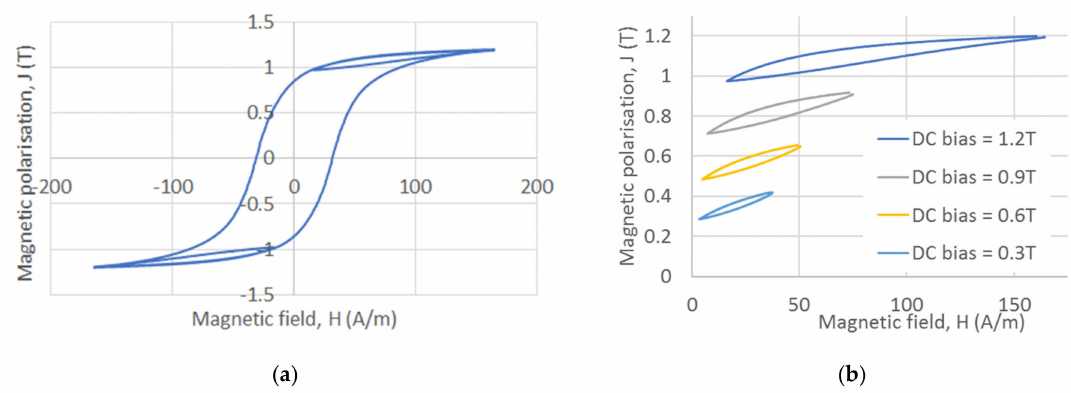
Figure 7. ( a ) Quasi-static waveform which includes a quasi-static minor loop and ( b ) shape of quasi-static minor loops for di ff erent DC bias fields.